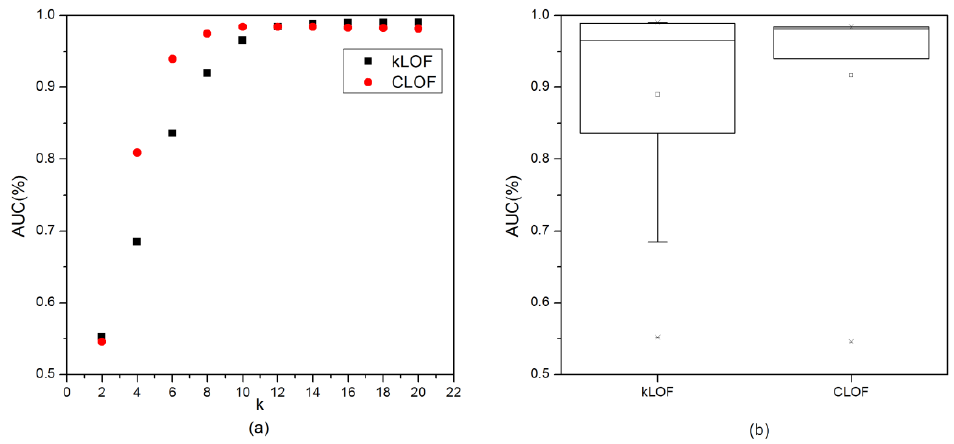
Figure 15. AUC values of kLOF and CLOF methods on the Shuttle dataset with different k related to t and the box plots for kLOF and CLOF: ( a ) the AUC values of kLOF and CLOF methods; ( b ) the box plots for kLOF and CLOF methods.